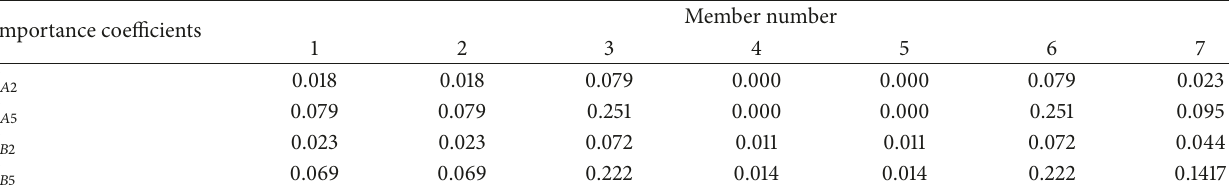
Table 1: Importance coefficients of each member for different load patterns.